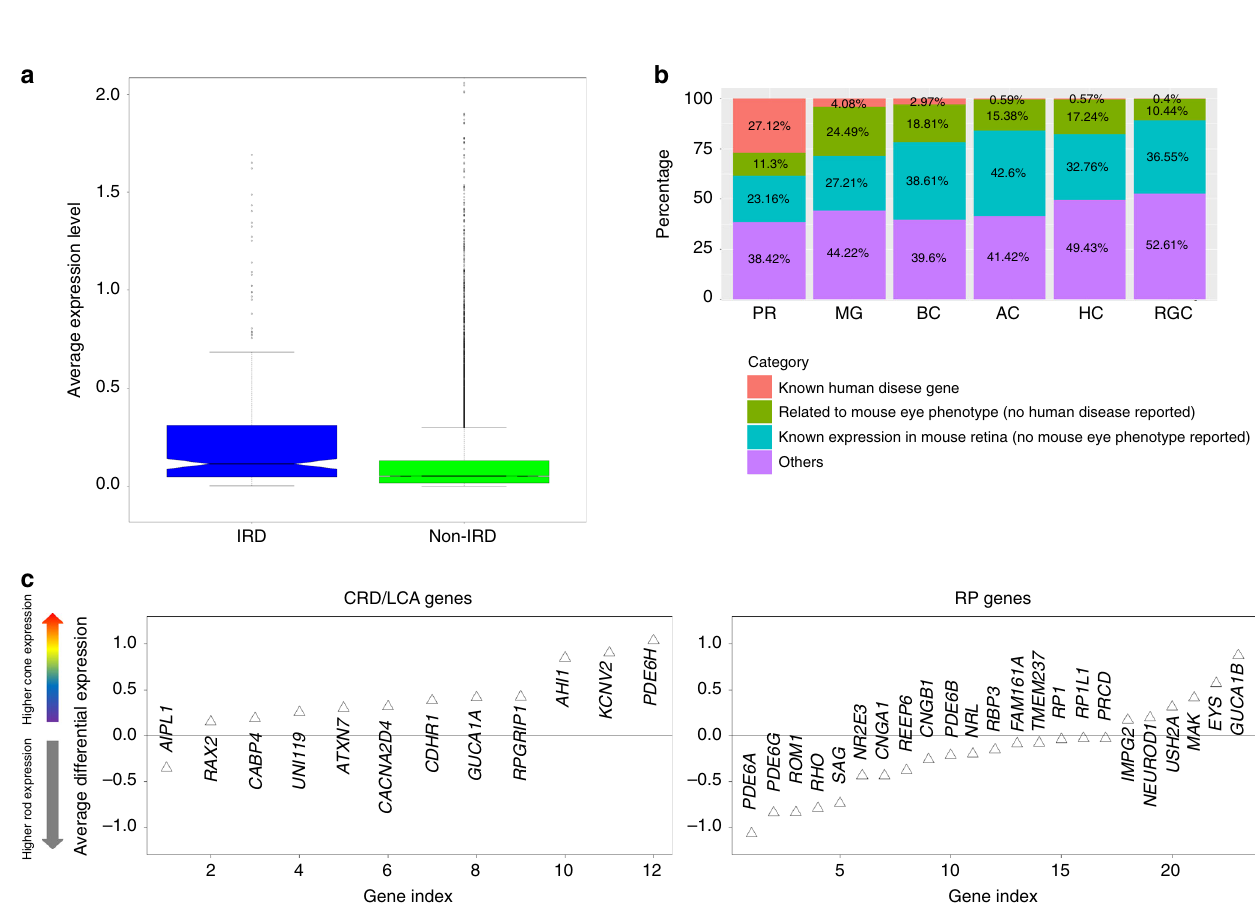
Fig. 4 Differentially expressed genes are revealed in rod and cone photoreceptors. a Gene ontology networks demonstrate the biological process GO terms enrichment by photoreceptor cell DEGs. All photoreceptor cell DEGs (177 genes) were used as input for the online software NetworkAnalyst 76 and only the terms with FDR adjusted p -value less than 0.05 were visualized. Terms were colored according to the p -value from low (red) to high (yellow). b Overlap of the hCOR (human cone-over-rod) and mCOR (mouse cone-over-rod) gene list and biological process GO term enriched in non-overlapping part. c Demonstration of the expression of CRD/LCA genes in the non-overlapping part of hCOR ( AHI1, ATXN7, KCNV2, PROM1, RD3, RPGRIP1 ) and mCOR ( GUCA1A ). In the box plots, bounds of the box spans from 25 to 75% percentile, center line represents median, and whiskers visualize 1.5 times inter- quartile range less than quartile 1 or 1.5 times inter-quartile range more than quartile 3 of all the data points. d Immuno fl uorescent staining for RD3 and RHO on human retina cryosections. White triangles and arrows highlight the fl uorescent signal of the cones and rods, respectively, in the top and bottom panel. Retinal cell layers are labeled in the bottom panel (OS outer segment, IS inner segment, ONL outer nuclear layer, OPL outer plexiform layer, INL inner nuclear layer, IPL inner plexiform layer, GCL ganglion cell layer). Scale bar is 20 μ m. e Immuno fl uorescent staining for RPGRIP1 and RHO on human retina cryosections. White triangles and arrows highlight the fl uorescent signal of the cones and rods, respectively, in the top and bottom panel. Retinal cell layers are labeled in the bottom panel. Scale bar is 20 μ m.